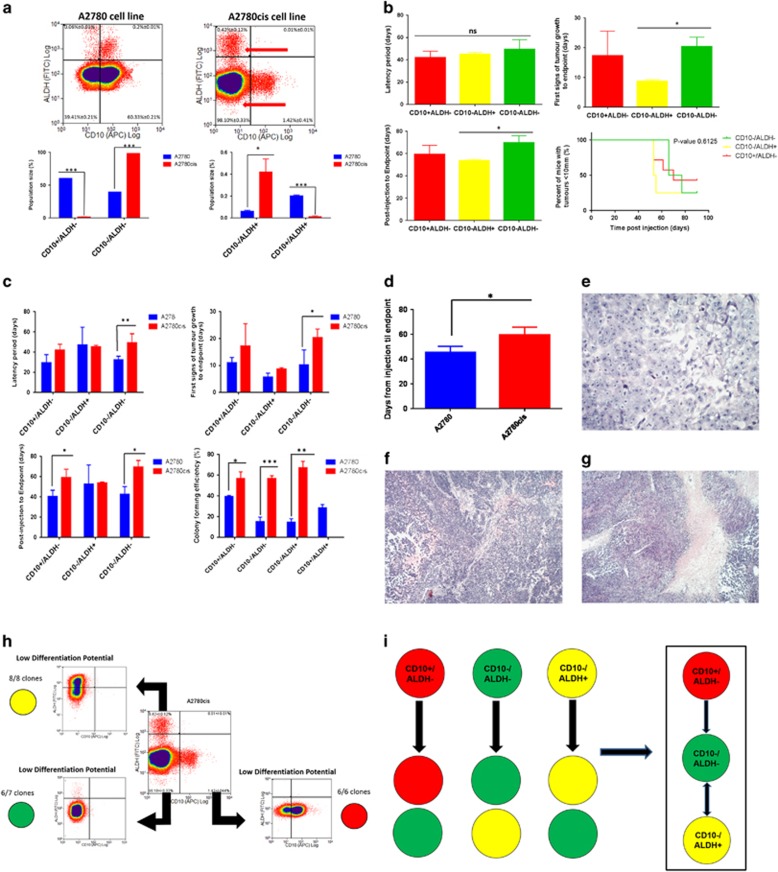
Cisplatin adaptation hard-wires changes to the CD10/ALDH ovCSC network. (a) Flow cytometric analysis indicated that the A2780cis model contained only three CD10/ALDH populations, as CD10+/ALDH+ cells were undetectable. This suggests that the altered flow cytometric profile observed when the A2780 model was treated with cisplatin for 96 h has been hard-wired in the A2780cis model. (b) All three populations could generate xenograft tumours from as little as 90 cells, validating them as true CSCs. Some differences were observed between CD10−/ALDH− and CD10−/ALDH+ CSCs (first sight of tumour growth, time from injection to end point, b, *P-value<0.05). There was no significant (NS) difference in latency period. (c) Additionally, it was noted that tumour formation and colony formation was slower in A2780cis CSCs compared with A2780 CSCs. A2780cis populations were found to more efficiently form colonies than A2780 populations (60±4% on average compared with 23±14%, respectively). (d) In addition, A2780cis populations were found to grow tumours significantly slower than A2780 populations. Histological analysis demonstrated an ovarian cancer-like pathology. (e): CD10−/ALDH−, (f): CD10−/ALDH+, (g): CD10+/ALDH−), with no consistent differences between the populations. (h) All three populations were plated as single cells and assessed for their relationship to one another via SCAD assay. (i) This analysis was summarised and modelled and indicated the absence of an obvious (potency-based) apex CSC in this network. Instead, it appears that both CD10−/ALDH+ and CD10+/ALDH− CSCs are now focussed on production of the cisplatin-resistant CD10−/ALDH− component. (Population mean comparison using analysis of variance test. Data shown are mean±S.D. of n⩾3 mice. Flow cytometric statistics presented as bar charts, NS=not significant, *P-value<0.05; ** P-value<0.01, ***P-value<0.001)